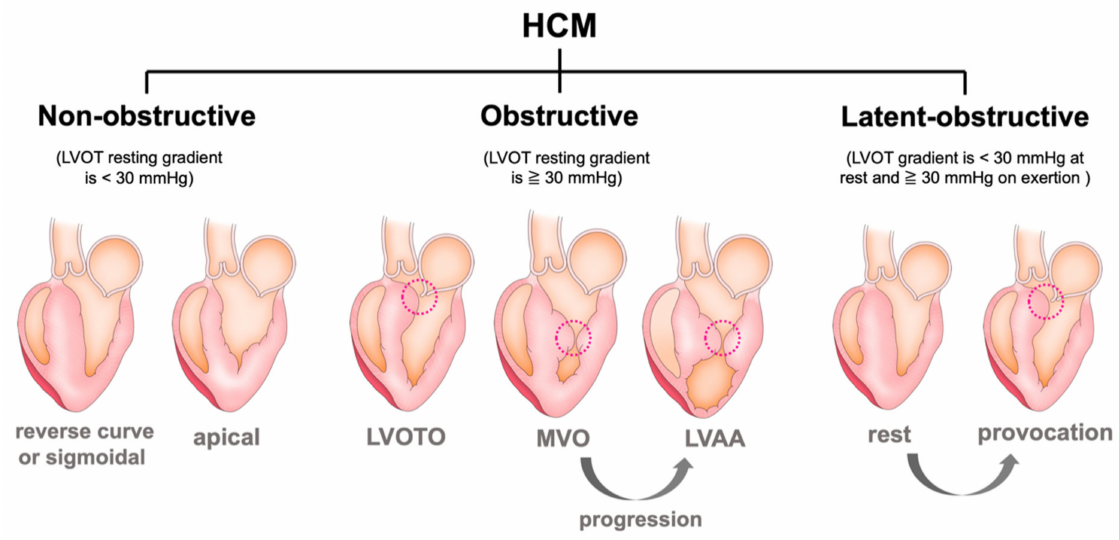
Figure 3. Schematic diagram of the different variants of HCM based on hemodynamic (obstructive vs. non-obstructive) classification. HCM = hypertrophic cardiomyopathy, LVOT = left ventricular outflow tract, LVOTO = left ventricular outflow tract obstruction, MVO = mid-ventricular obstruction, and LVAA = left ventricular apical